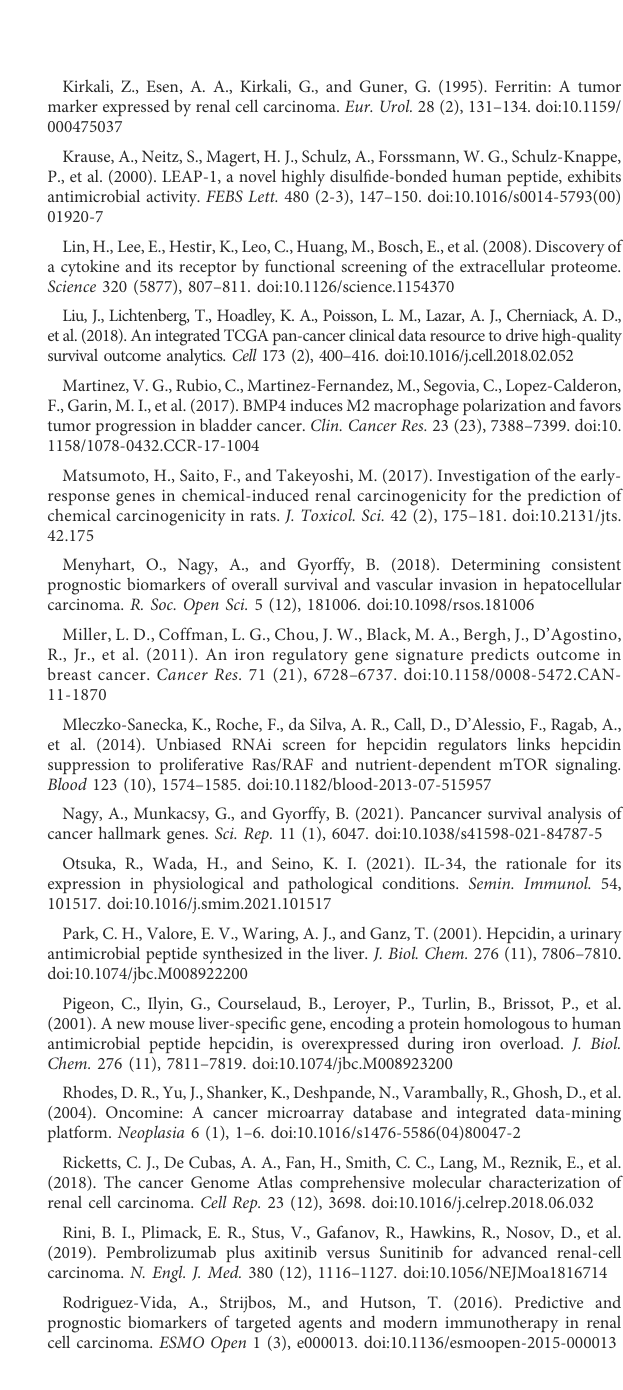
SUPPLEMENTARY TABLE S2 Relationship of HAMP expression with clinicopathological parameters in pRCC patients. SUPPLEMENTARY TABLE S3 Relationship of HAMP expression with clinicopathological parameters in ChRCC